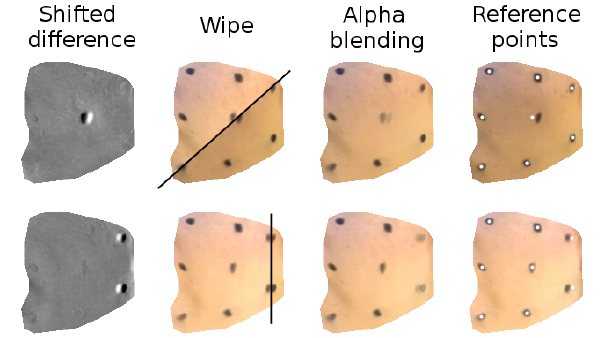
Fig. 2 Assessment tools. Top: frame 156, bottom: frame 200, in Fig. 1.